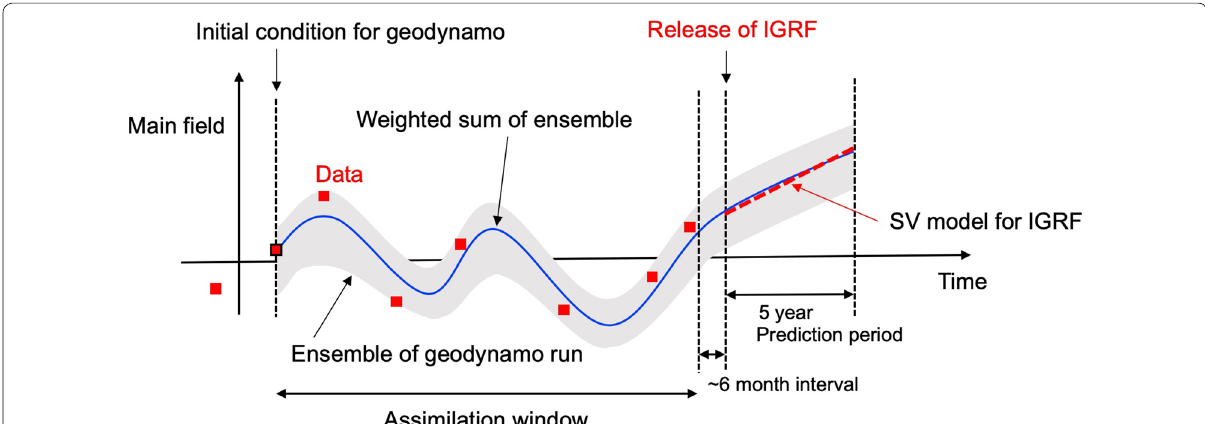
Fig. 1 A schematic figure of the 4DEnVar and prediction of the future geomagnetic field. The weighted sum of an ensemble of dynamo run (the thick blue line) is the final estimate after the assimilation corresponding to Eq. 13. The SV candidate model for IGRF-13SV (the red dashed line) is determined by line-fitting to the MHD expectation of the next 5 years. One can use geomagnetic data up to ~ 6 months before the release of IGRF for generation of candidate models because the deadline of their submissions is ~ 3 months before the release (October 1st for